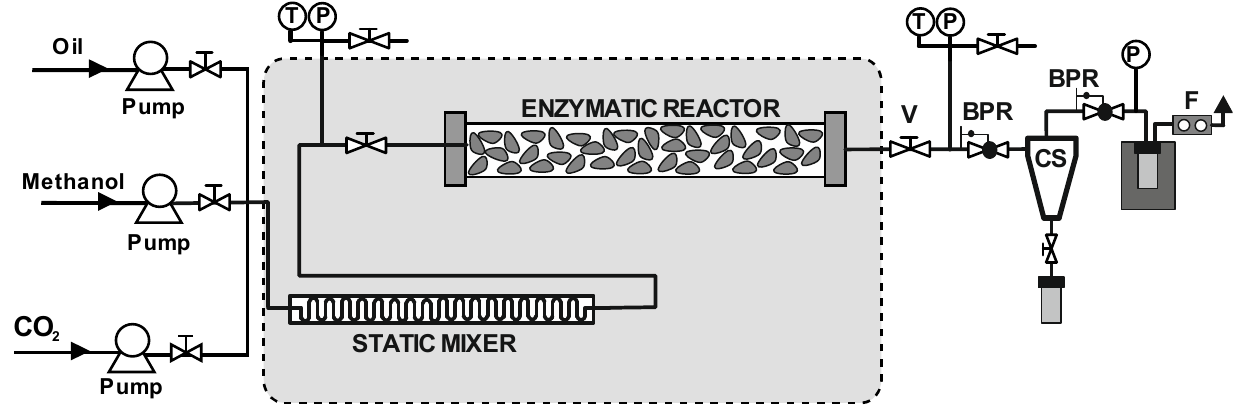
Figure 7. Set-up of the continuous enzymatic reactor for biodiesel synthesis [84]. T: temperature indicator; P: pressure indicator; V: valve; BPR: Back-pressure regulator; CS: cyclone separator; F: